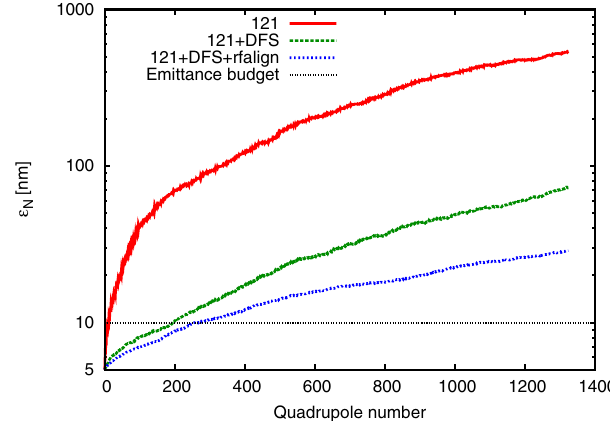
FIG. 1. Average emittance along 100 random CLIC main linacs for different beam-based alignment schemes. By using one-to-one (121) steering, DFS, and finally realigning the accel- erating structures (rfalign), the emittance growth can be reduced to 23.8 nm. To achieve the emittance growth target of 5 nm, the additional use of tuning bumps